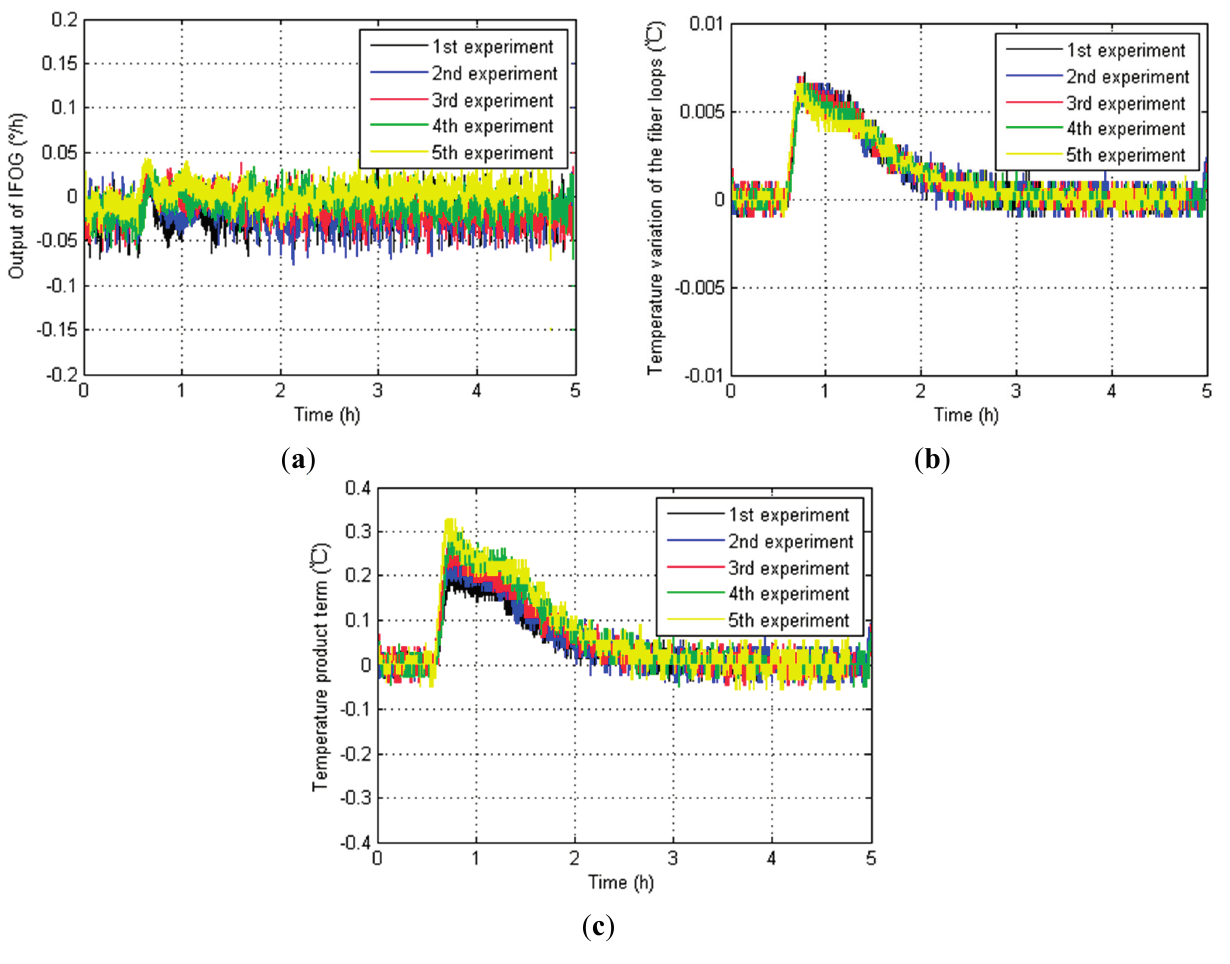
Figure 8. Relevant test results from NO.2 IFOG. ( a ) IFOG outputs; ( b ) Fiber loop temperature variation ∆ T ; ( c ) Temperature product term T × ∆ T .